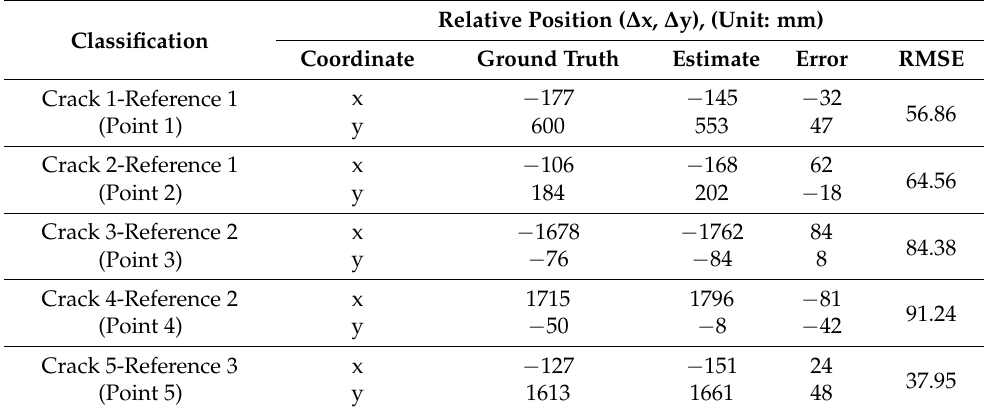
Table 5. Comparison of estimated relative positions and measured relative positions values.